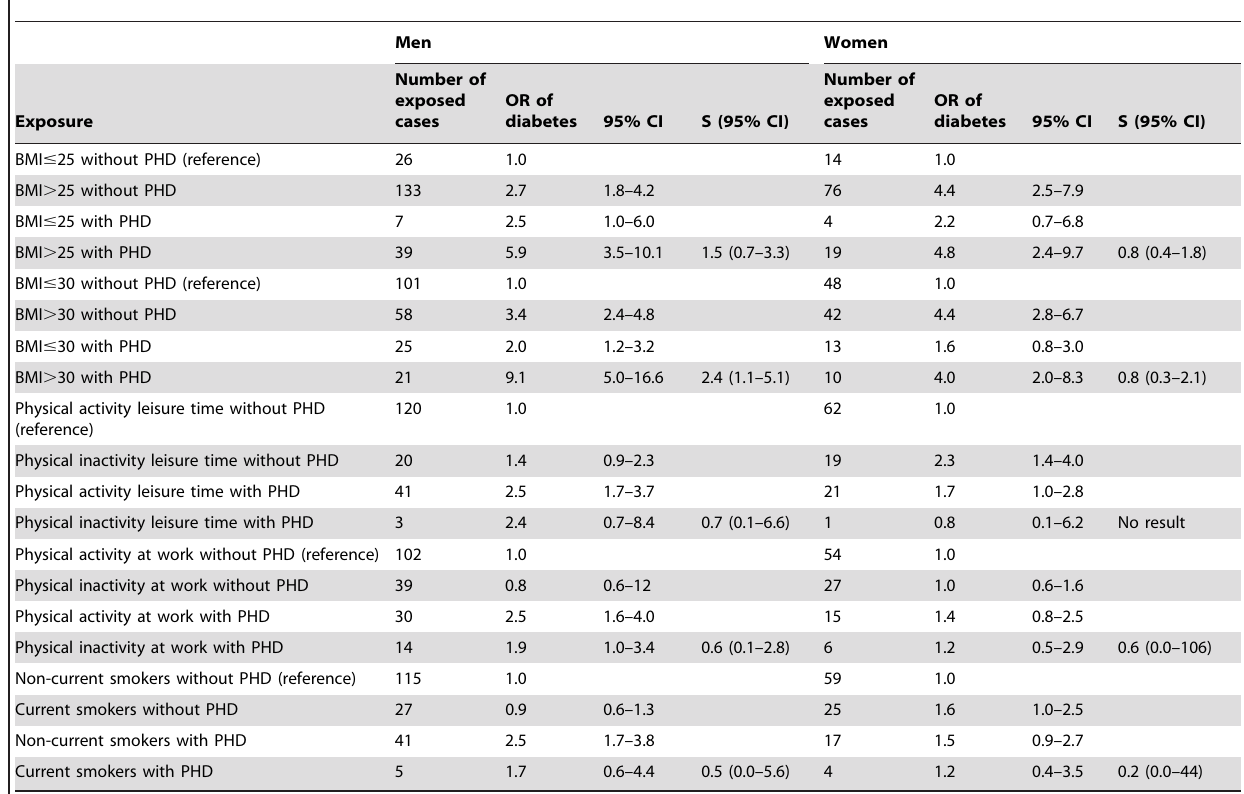
Table 3. Interaction effects for parental history of diabetes in combination with high BMI, physical inactivity and smoking,